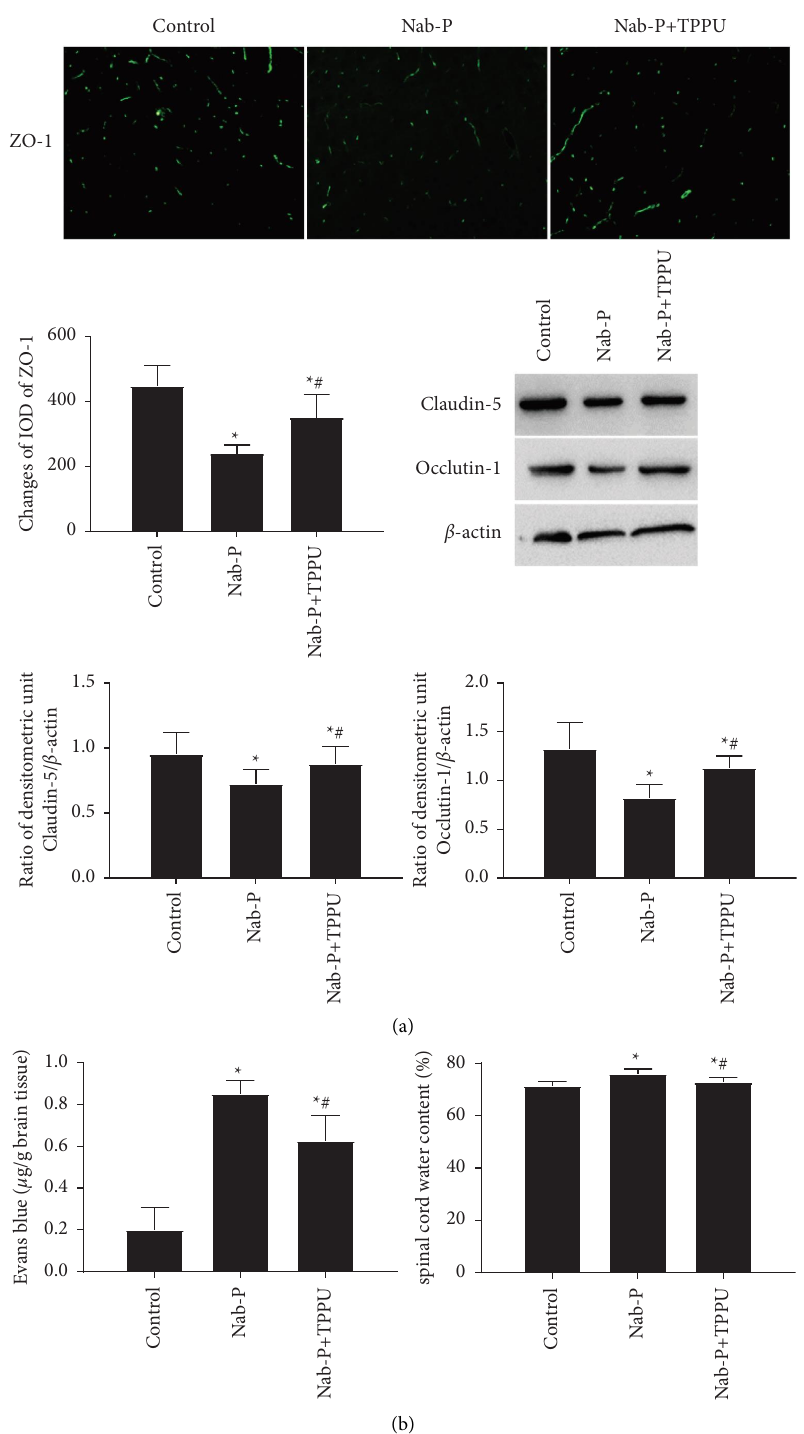
Figure 4: Te efect of the sEH inhibitor TPPU on vascular permeability in the spinal cord after nab-paclitaxel administration. (a) Te expressions of ZO-1, claudin-5, and occludin-1 were assessed by immunofuorescence staining and western blotting analysis. (b) Te bar graphs show the statistical results of the Evans blue and spinal cord water content. n � 6; ∗ P < 0 . 05, compared with the control group; # P < 0 . 05, compared with the nab-P